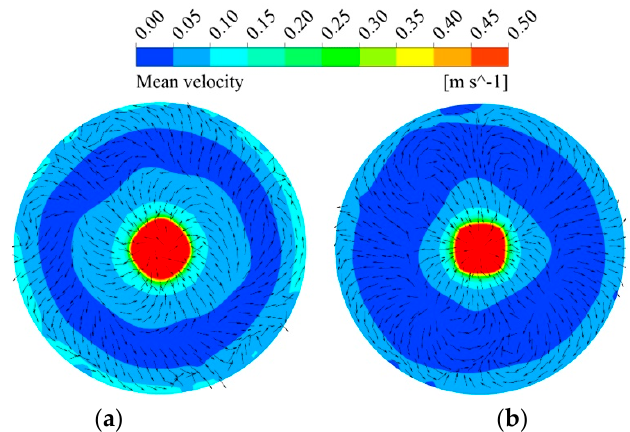
Figure 7. Simulated results of mean velocity profiles ( a ) with a swirler and ( b ) without a swirler.